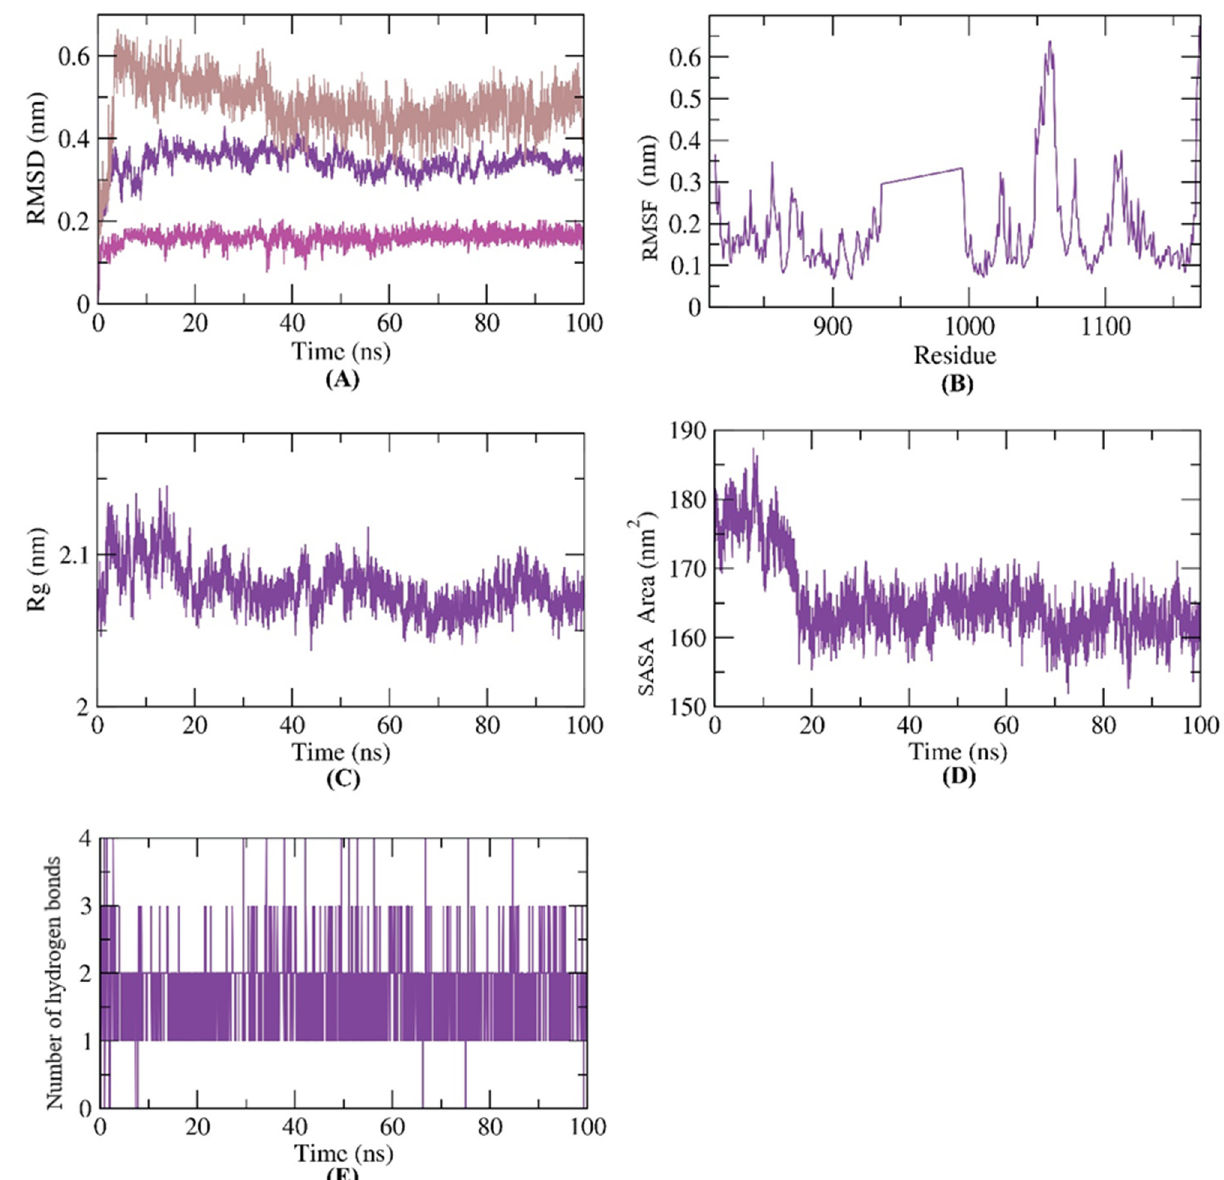
Figure 9. The findings of the MD simulations of compound 6 ‐ VEGFR ‐ 2 complex over100 ns; ( A ) RMSD showing no major fluctuations, ( B) RMSF showing slight flexibility of VEGFER ‐ 2 in 1050– 1070 residue areas, ( C ) R g showing a high degree of stability and no major fluctuations, ( D ) SASA showing considerable decreasing and stable values and ( E ) H ‐ bonding showing the formation of up to four hydrogen bonds.